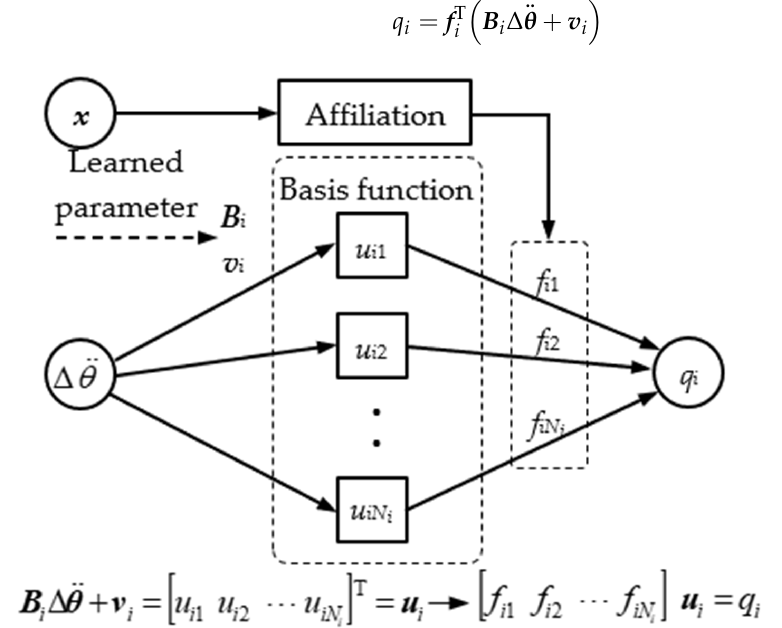
Figure 6. Structure of the RBF network.